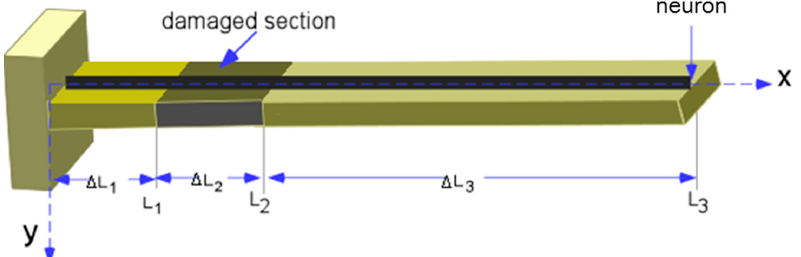
Figure 8. Damaged cantilever beam with a strain neuron.